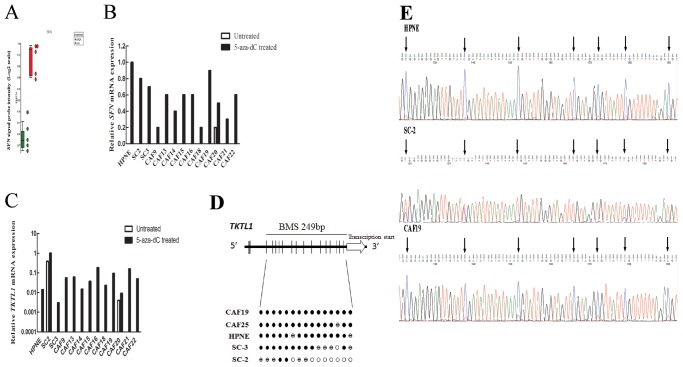
Effect of 5-aza-dC treatment on SFN and TKTL1 mRNA expression in 5-aza-dC treated pancreatic CAFs and control fibroblasts, and bisulfite sequencing analysis of TKTL1.(A) Affymetrix exon array analysis of SFN mRNA expression in five pancreatic CAFs before (green) and after (red) 5-aza-dC treatment. (B) and (C) Quantitative RT-PCR analysis of SFN and TKTL1 mRNA expression relative to GAPDH mRNA in pancreatic fibroblast cultures before (blue bars) and after (red bars) 5-aza-dC treatment. Each assay was performed in triplicate. Data are means of three independent experiments; bars are SD values. (D) Top: TKTL1 gene structure and distribution of CpG dinucleotides. Short vertical bars represent CpG sites. Arrow points to transcriptional start site. Below: Bisulfite genomic sequencing analysis in pancreatic CAFs and control fibroblasts. Open circles represent unmethylated CpG sites, solid black circles methylated CpG sites, and hatched circles partially methylated CpG sites. (E) Bisulfite sequencing chromatograms of the TKTL1 promoter in a pancreatic CAF (CAF19) and control fibroblast lines (HPNE and SC2). Arrows point to cytosine residues.